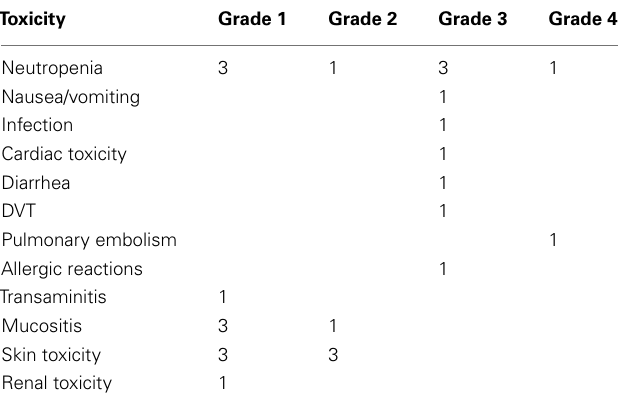
Table 5 | Summary of toxicity ofTPF-C chemotherapy.